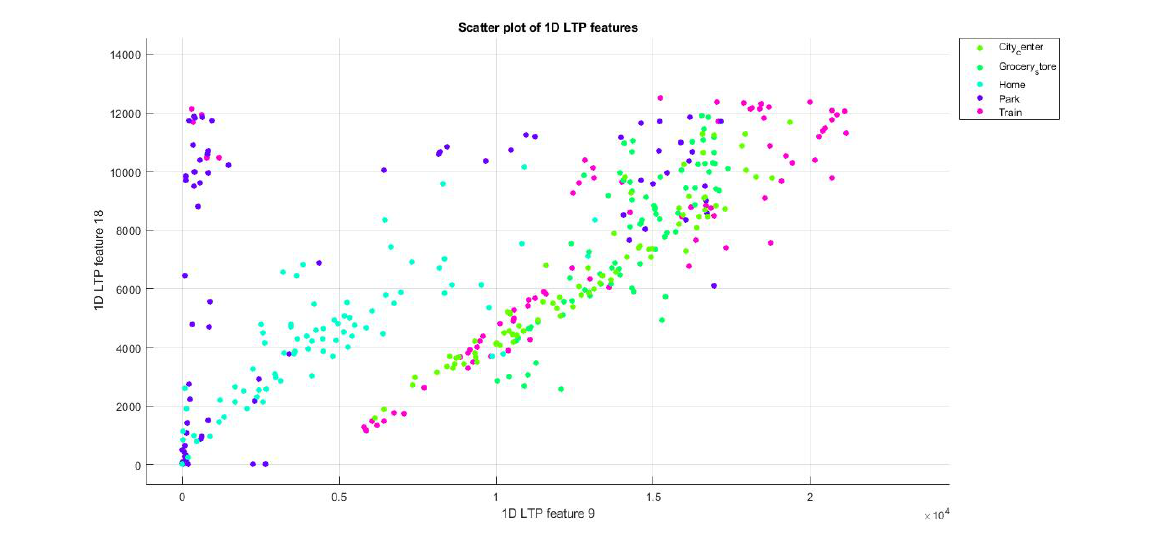
Figure 5. Scatter plot of ID-LTPs of DCASE dataset.